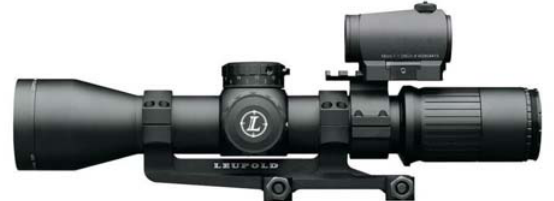
Рис . 8 – Оптический прицел Leupold Mark4 4.5-14x50 Side Focus CDS Слика 8 – Оптички нишан Leupold Mark4 4.5-14×50 Side Focus CDS Table 8 – Technical and technological characteristics of the Leupold Mark4 4.5-14x50 Side Focus optical sight (Leupold, 2018) Таблица 8 – Технико - технологические характеристики оптического